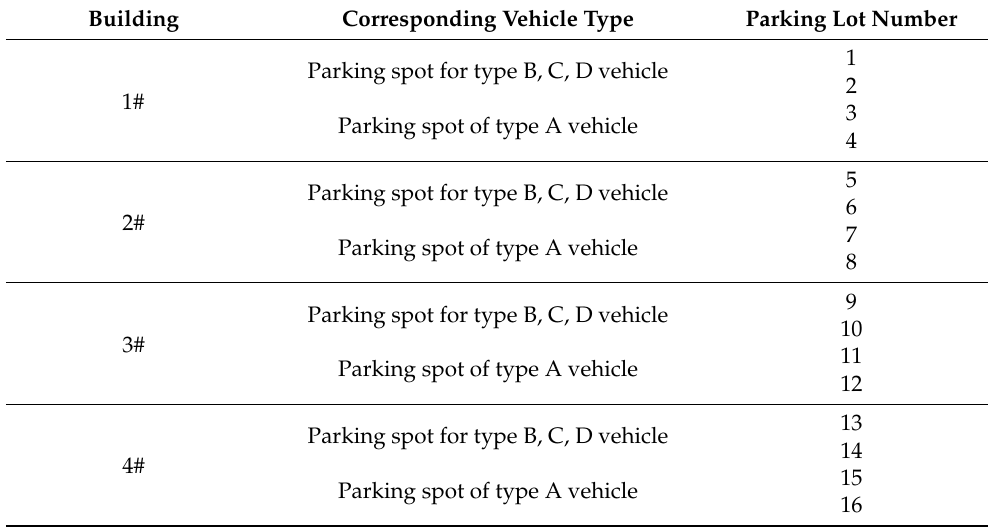
Table 4. Table of the parking spot and the corresponding vehicle